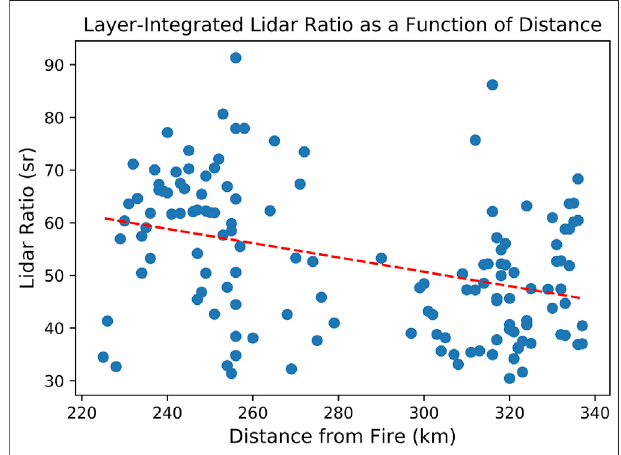
FIGURE 4 | Evolution of the 532 nm layer-integrated lidar ratio calculated using the signal loss technique for the Williams Flats Fire as a function of distance from the fi